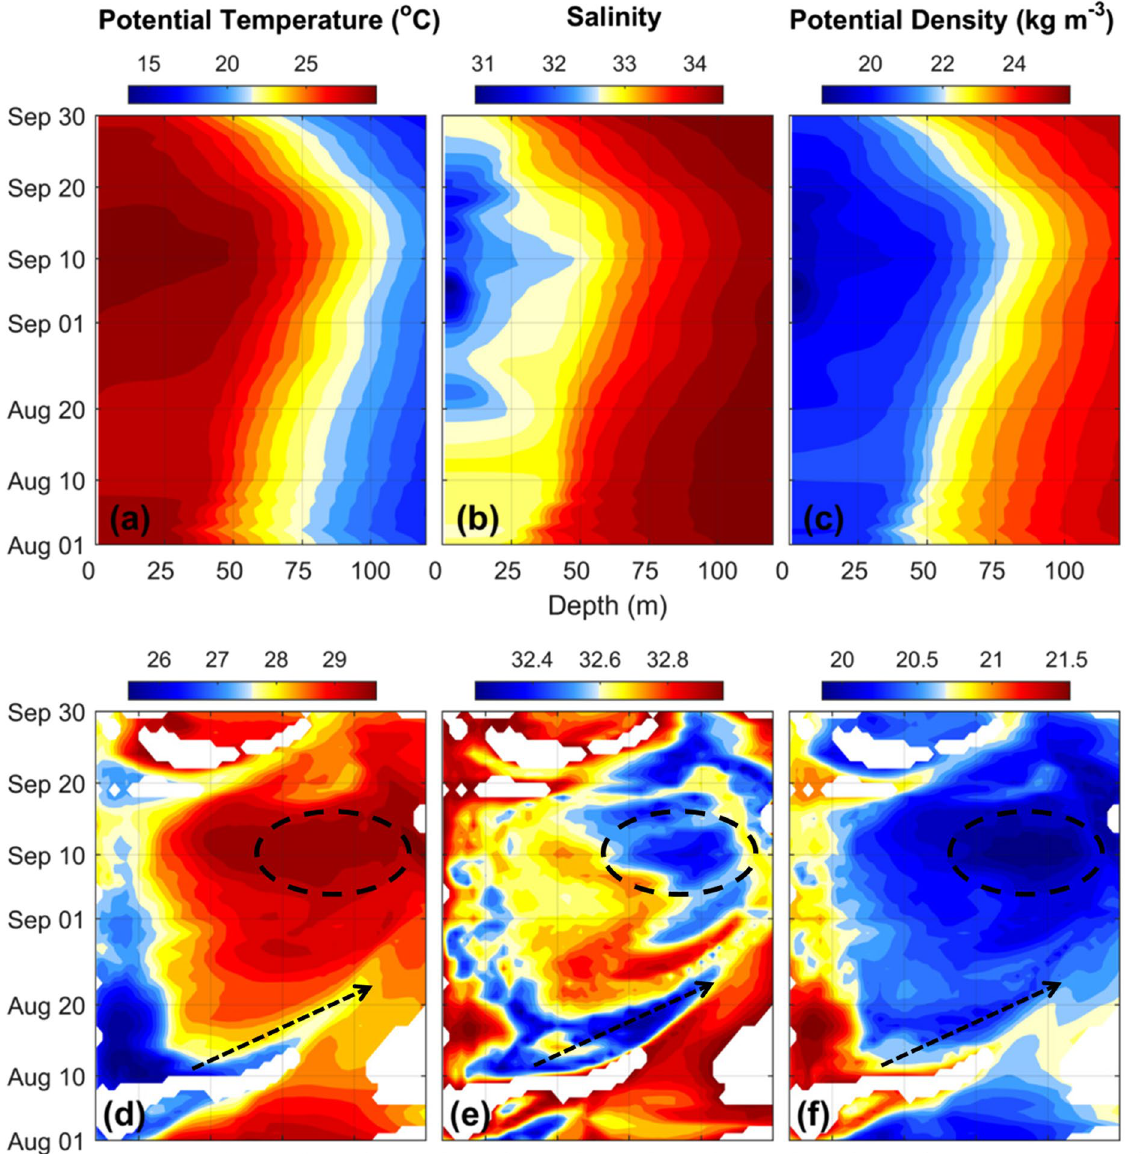
Figure 6. Hovmöller plots of thermohaline properties. Top: time–depth plots of ( a ) θ , ( b ) S and ( c ) σ θ horizontally averaged between 111°–113°E. Bottom: time–longitude plots of ( d ) θ , ( e ) S and ( f ) σ θ vertically averaged between isohalines 32 and 33. Dashed arrows denote eastward propagation; dashed circles indicate the stagnant waters. Blank indicates sea surface salinity higher than 33. The figure is generated using Matlab R2011a